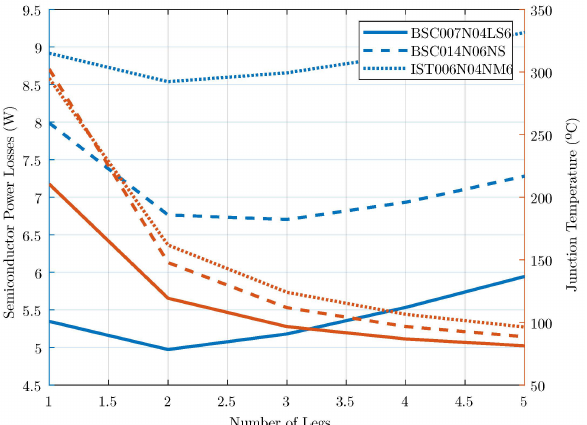
Figure 6. Semiconductor power losses (blue lines) and the estimated junction temperature (red